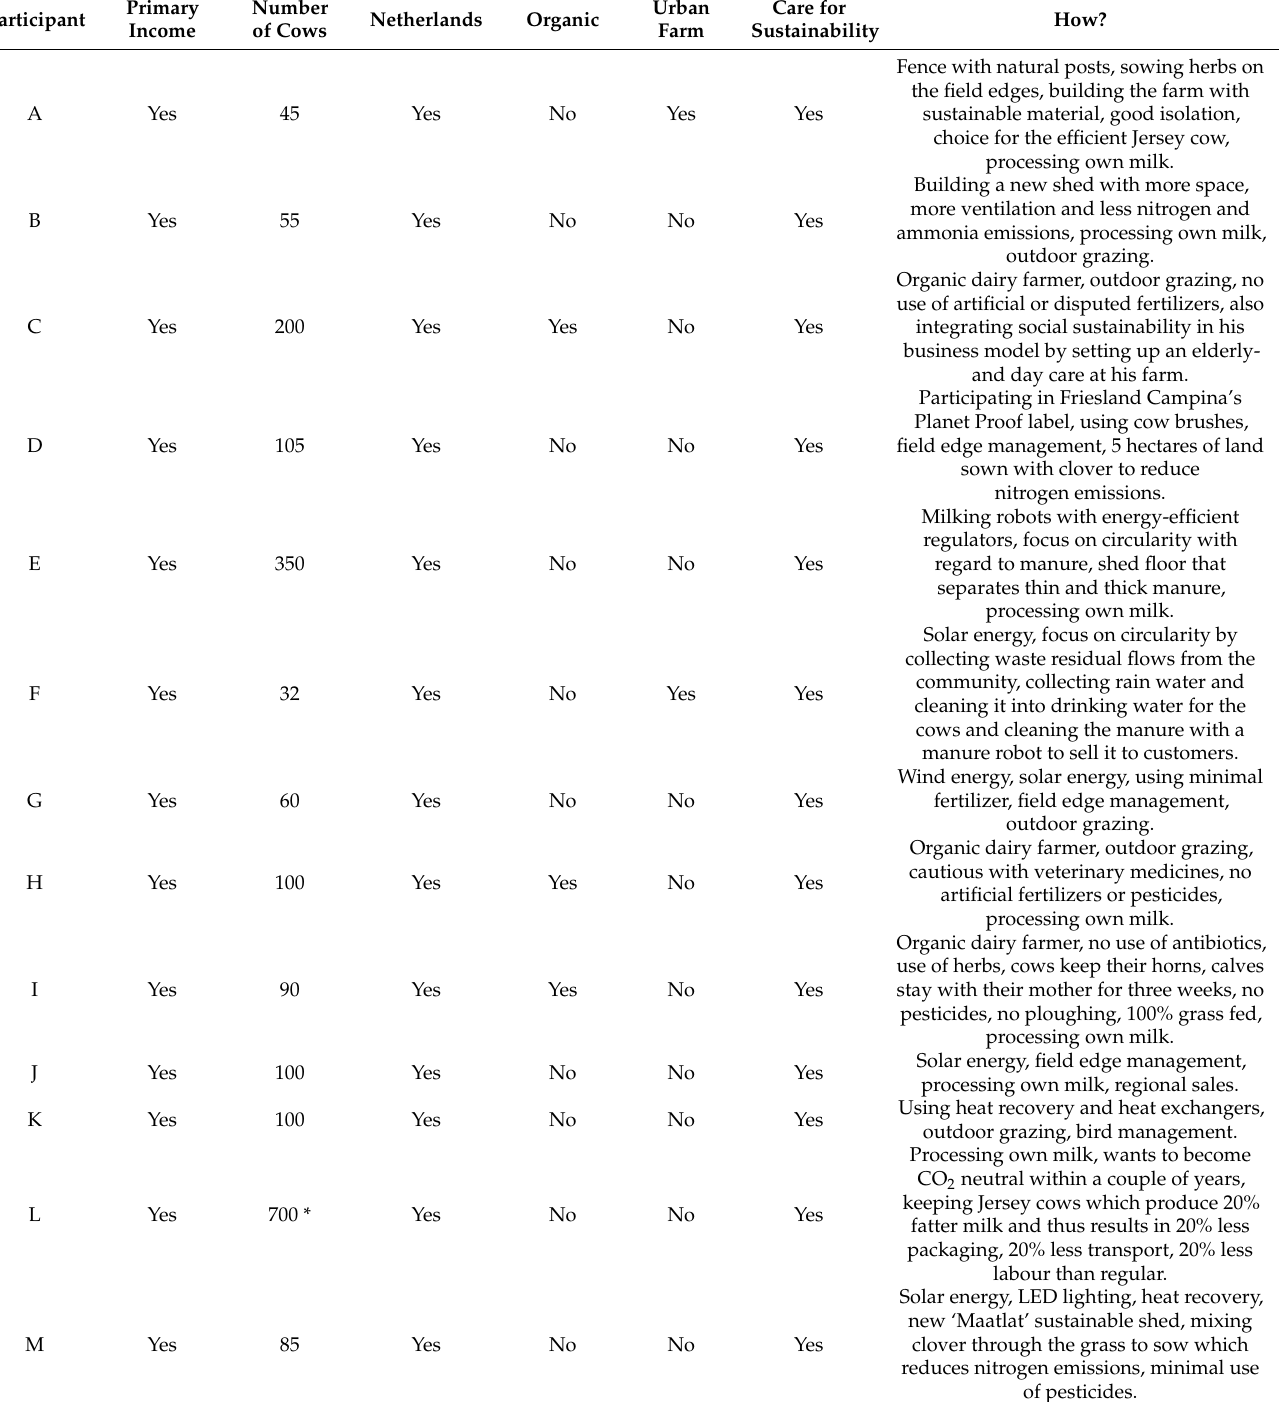
Table 1. Characteristics of the selected case